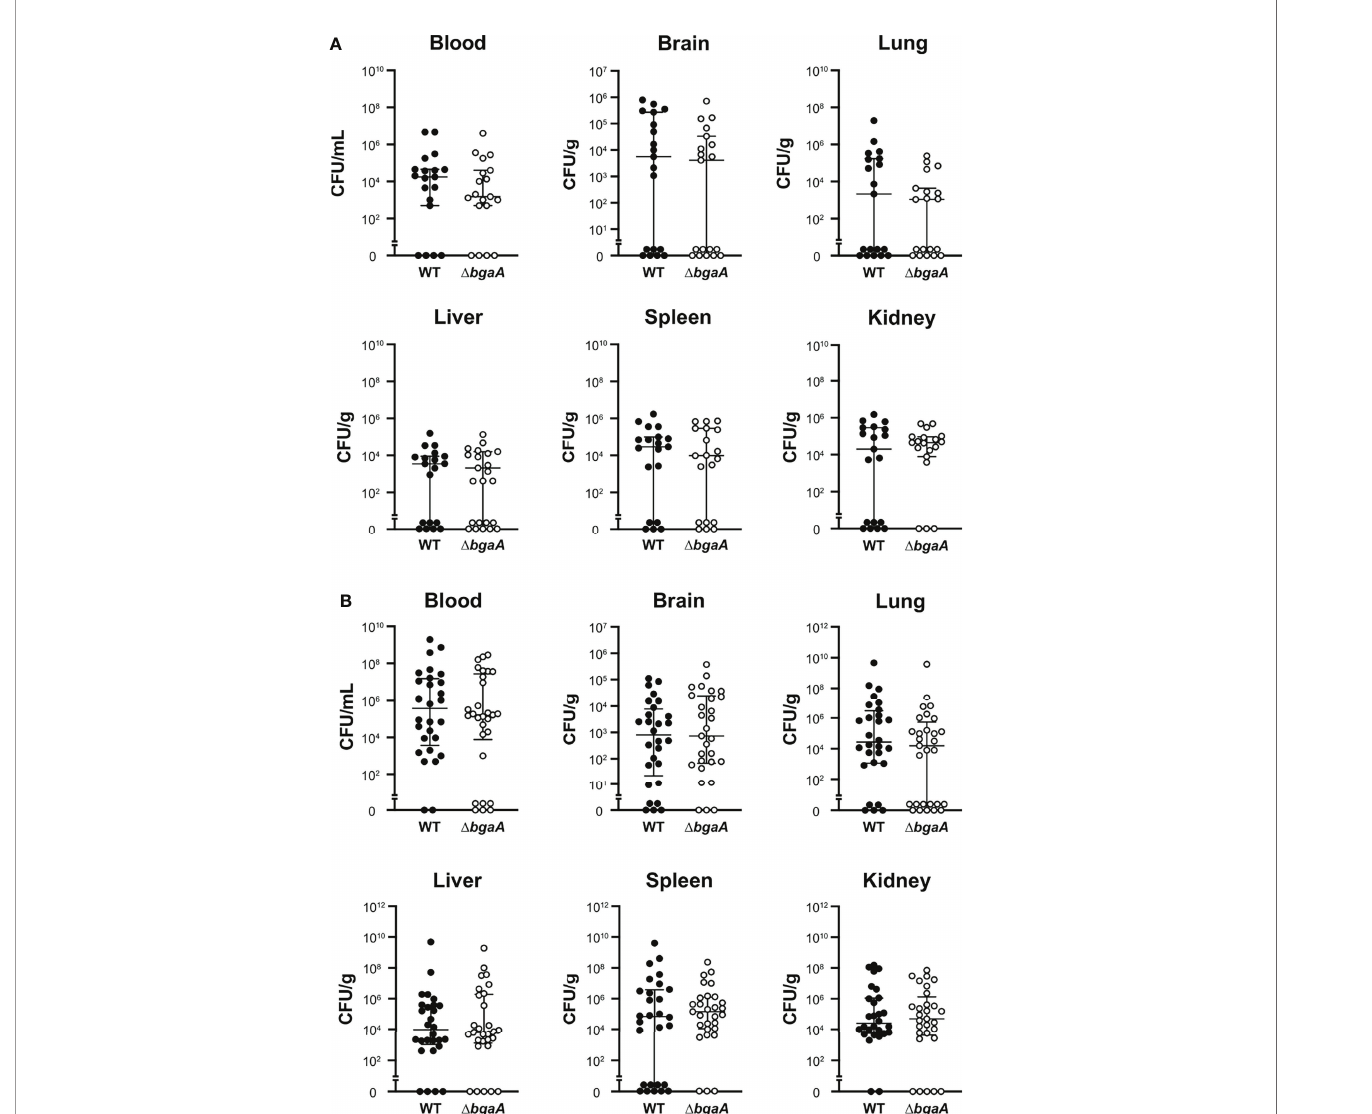
FIGURE 2 | De fi ciency of bgaA did not affect the bacterial burden in mice. Mice were infected by intravenous injection of S. pneumoniae TIGR4 wild type or D bgaA. The bacterial burden in the blood, brain, lung, liver, spleen, and kidney was assessed after 24 h (A) or 36 h (B) of infection. The median and IQR values are represented using vertical lines. All mice were perfused with PBS after blood collection, and organ samples were collected. Statistical differences between groups were analyzed using the Mann – Whitney U test. The bacterial burden values obtained from the four independent experiments were pooled. Individual values are provided in Supplementary Data 2